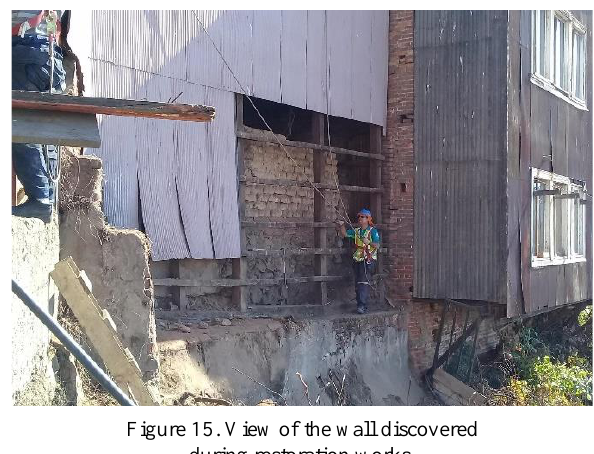
Figure 15. View of the wall discovered during restoration